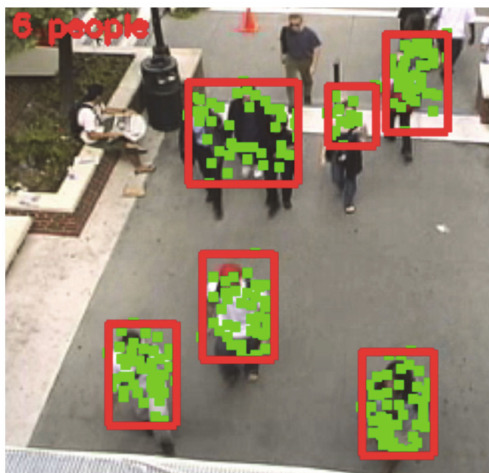
Figure 7. Example of the application result of the Algorithm 1 (computer